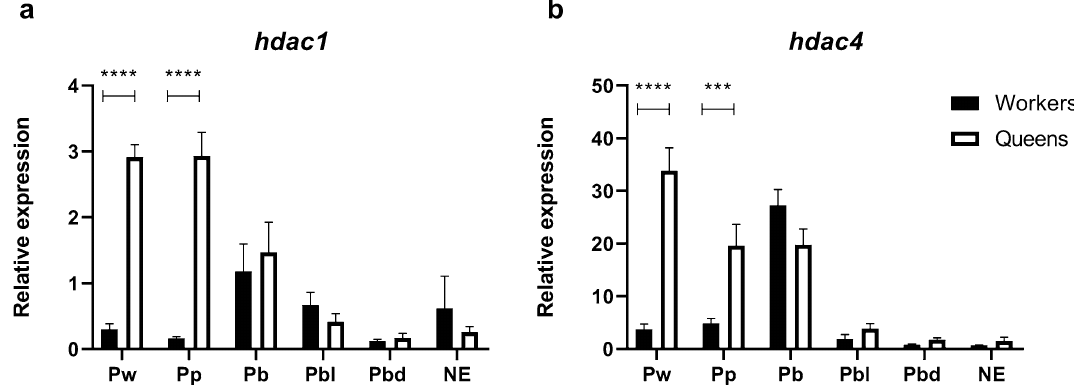
Figure 2. Expression of HDACs genes in Melipona scutellaris workers and queens. Relative expression of hdac1 ( a ) and hdac4 ( b ) quantified by RT-qPCR. Pw = pupa with white body and eyes; Pp = pupa with white body and pink eyes; Pb = pupa with white body and brown eyes; Pbl = pupa with light pigmented body and brown eyes; Pbd = pupa with dark pigmented body and brown eyes; NE = newly emerged adult. The graphs show mean ± SEM (n ≥ 3). Statistical analysis: 2Way-ANOVA with a post-hoc Sidak’s multiple comparisons test, P <